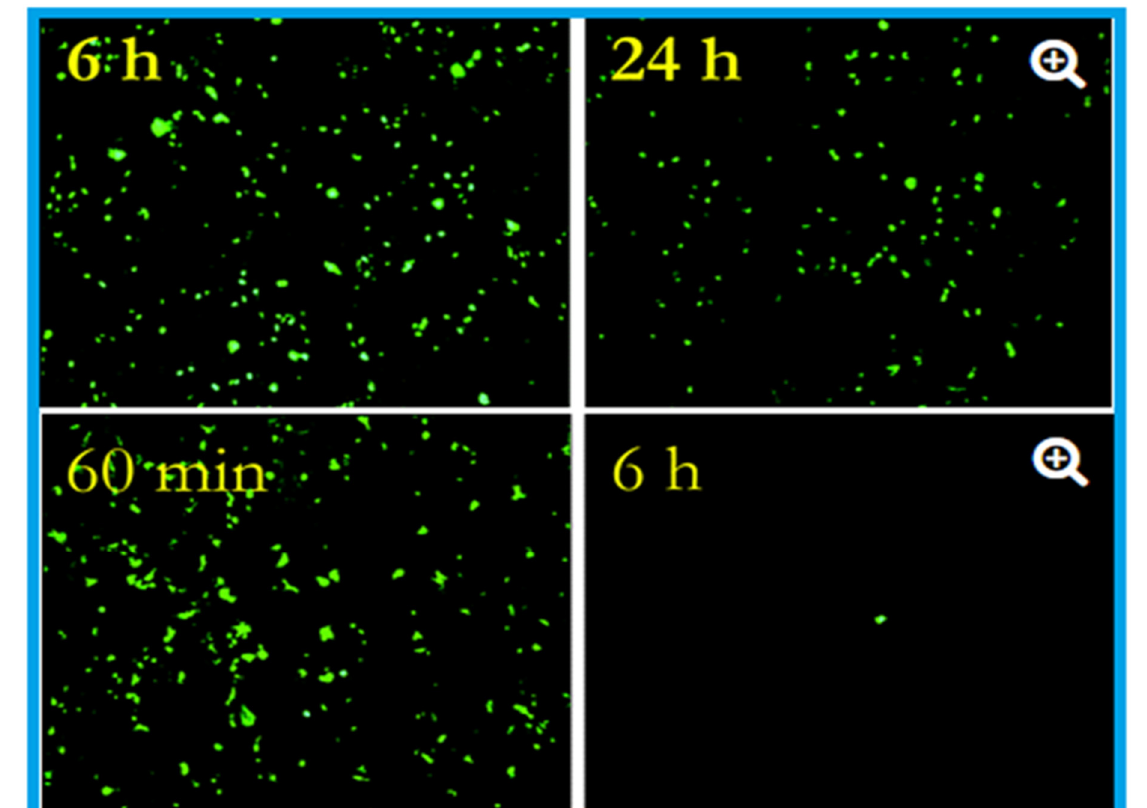
Figure 1. Effects of influenza A virus on steel surface (top) and copper surface (bottom). The influenza virus was cultured in R-mix vials that contain a monolayer of mink lung and human laryngeal carcinoma cells grown on glass coverslips. This was inoculated into sterile coupons of copper (C11000) and steel (20 µL virus suspension with 10 8 virus particles per millilitre) for the experimental purpose and kept at room temperature (22 ± 2 °C) with a relative humidity of 50 to 60%. Here in the epifluorescent image, the number of green fluorescing cells are proportional to the viral inoculum. After six hours, 10 6 virus particles were found to be remained viable on the steel surface, and after 24 h, 5 × 10 5 particles were present, capable of causing cell infection (top). In contrast to the steel surface, on copper, the virus particles reduce to 5 × 10 5 after 60 min (the equivalent of 24 h of exposure on stainless steel), which reduced to 5 × 10 2 after six hours (nearly 4 log reduction). After 24 h of incubation, 500,000 virus particles were present on stainless steel, but 500 only seen after six hours on the copper surface. Adapted with permission from Ref. [92]. Copyright 2007, American Society for Microbiology.